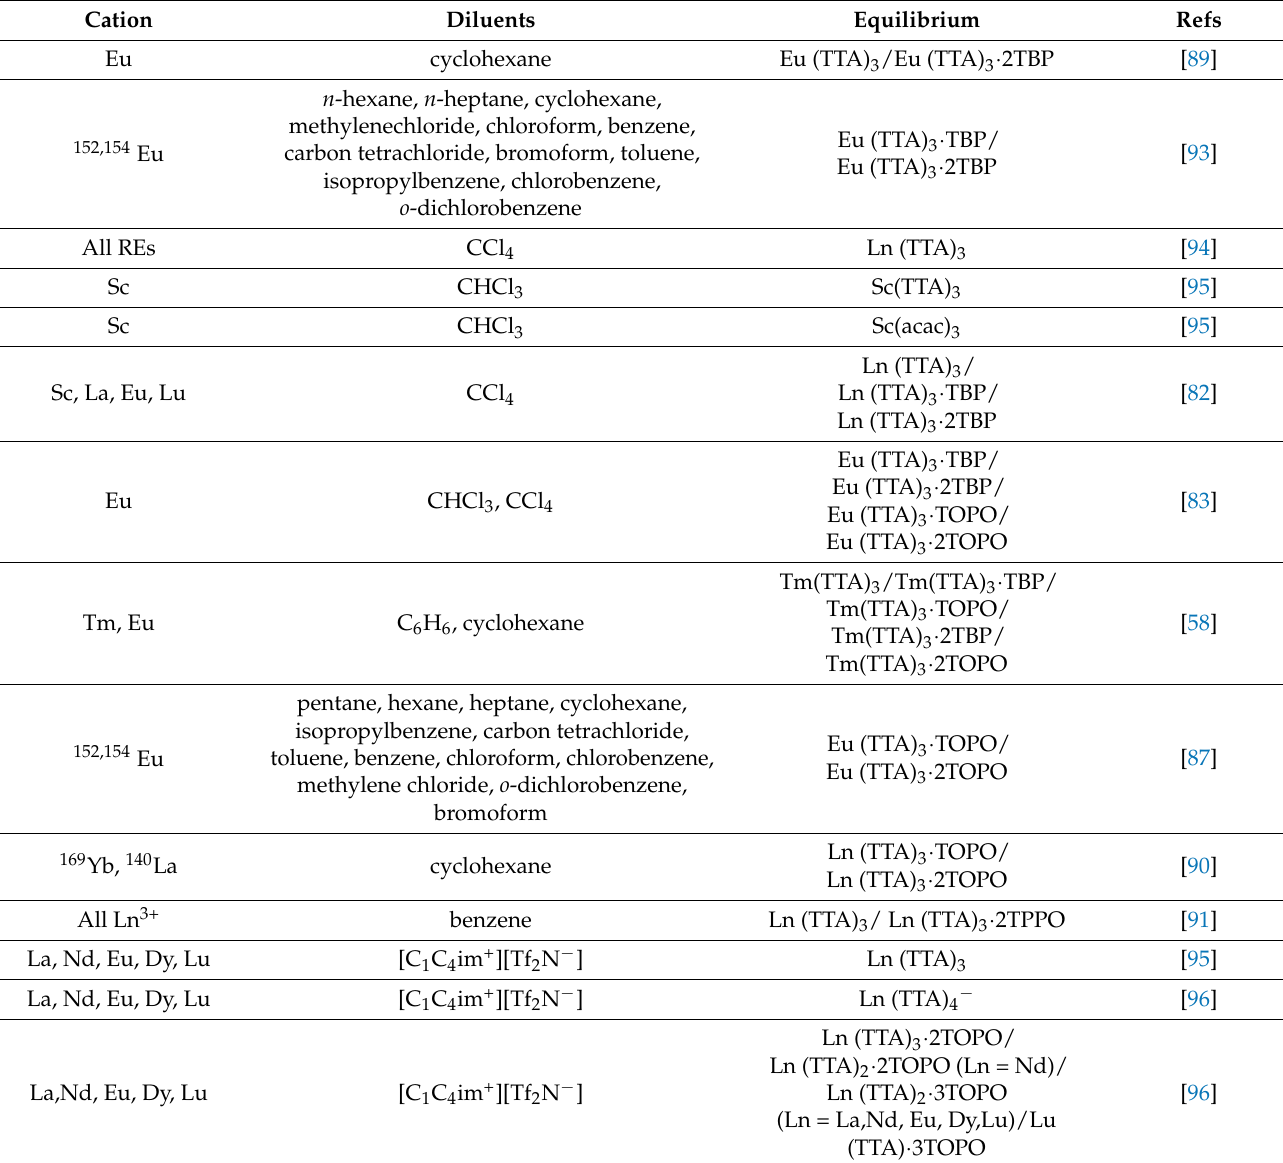
Table 5. Summary of synergistic systems of thenoyltrifluoroacetone with an organophosphorus ligand for the solvent extraction of trivalent